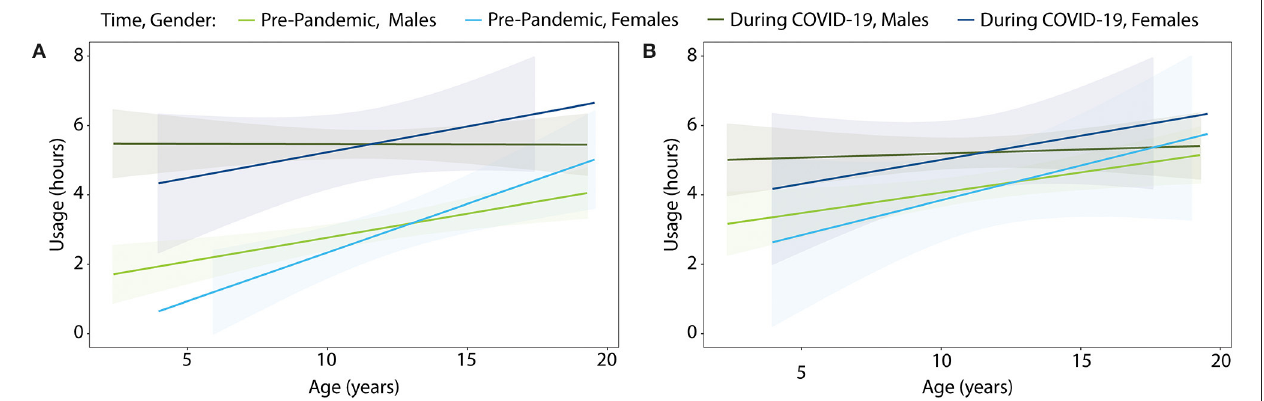
FIGURE 1 | Screen time usage by age for children with ASD before and during the COVID-19 school closures on (A) weekdays and (B) weekends. Colored shading denotes 95% confidence interval.